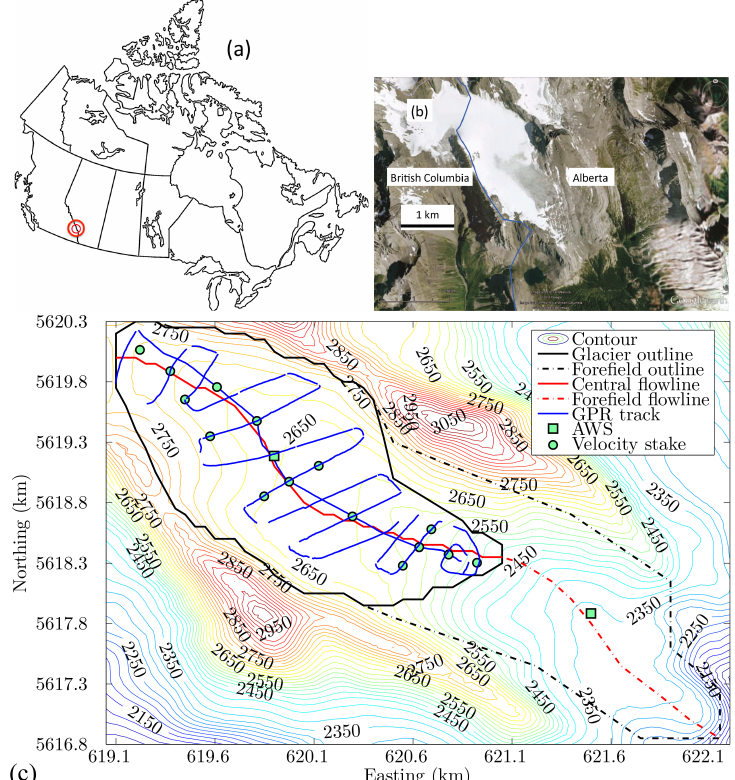
Fig. 1. Overview of Haig Glacier. (a) Map of Canada, showing the location of Haig Glacier (red circle). (b) Bird’s-eye view of the glacier (image courtesy of Google © 2012). Blue line shows the continental divide bordering Alberta and British Columbia. (c) Summary of geo- physical data measurements in 2009/2010. Blue curves are the ground penetrating radar (GPR) survey tracks. Circles are the positions of velocity stakes on 24 May 2009. Squares represent two automatic weather stations (AWS). Solid black and red lines show the present-day glacier outline and the central flowline, respectively; dashed lines are their extension in the glacier